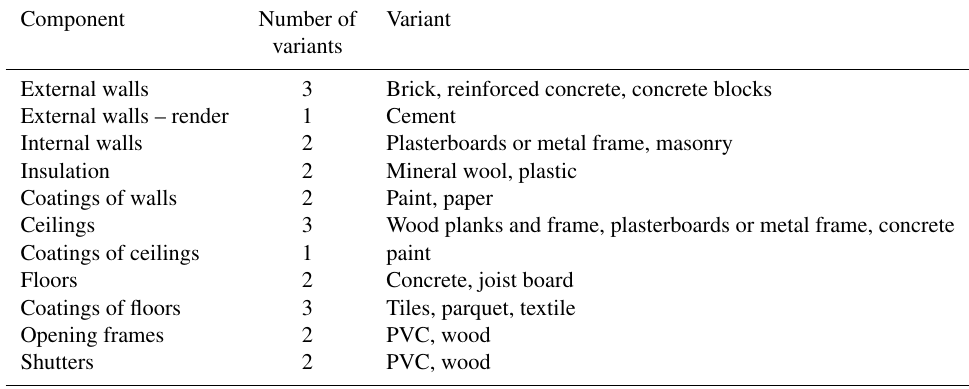
Table 3. Components of the building used to develop the versions of the numerical models of dwellings. Component Number of Variant variants External walls 3 Brick, reinforced concrete, concrete blocks External walls – render 1 Cement Internal walls 2 Plasterboards or metal frame, masonry Insulation 2 Mineral wool, plastic Coatings of walls 2 Paint, paper Ceilings 3 Wood planks and frame, plasterboards or metal frame, concrete Coatings of ceilings 1 paint Floors 2 Concrete, joist board Coatings of floors 3 Tiles, parquet, textile Opening frames 2 PVC, wood Shutters 2 PVC,